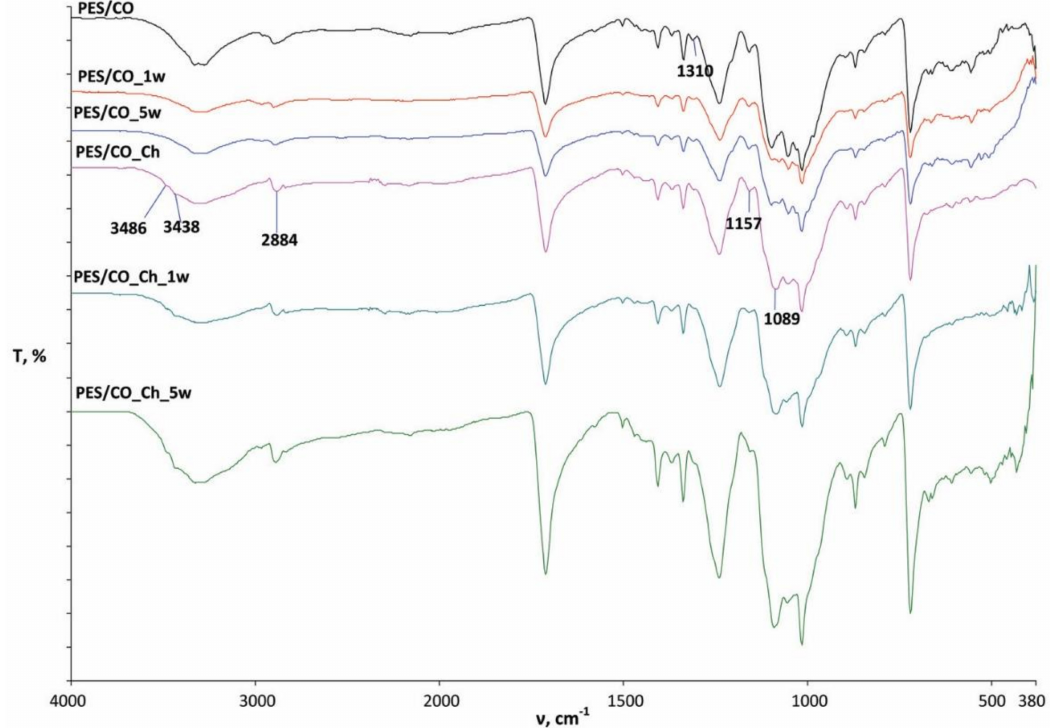
Figure 7. Polyester / cotton (PES / CO) blend fabric and the spectral bands of the treated samples (PES / CO_Ch) and after first (PES / CO_1w, PES / CO_Ch_1w) and fifth washing cycle (PES / C_5w, PES /